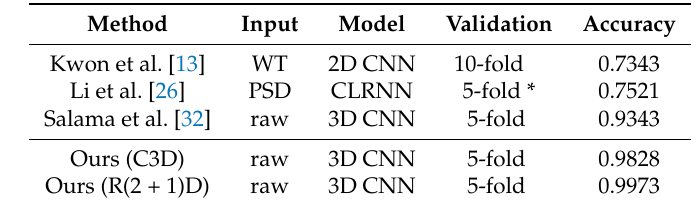
Table 3. Average accuracies of 4-class classification using different approaches on the DEAP dataset. (* in the validation denotes subject-wise